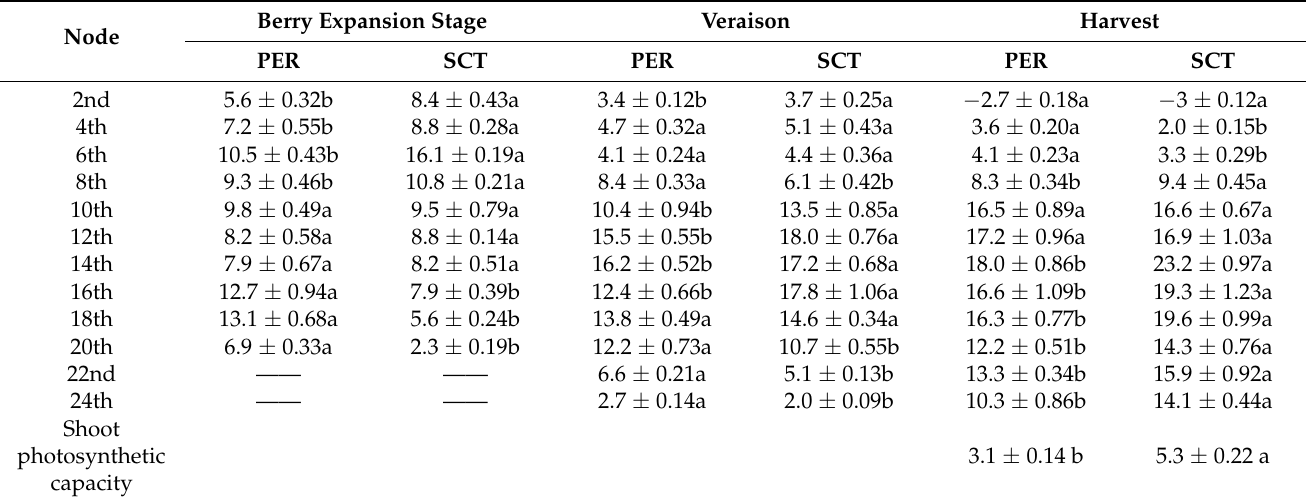
Table 1. Photosynthetic rates ( µ mol · m − 2 · s − 1 ) of leaves from different nodes at different growth stages of PER (pergola) and SCT (single-curtain training